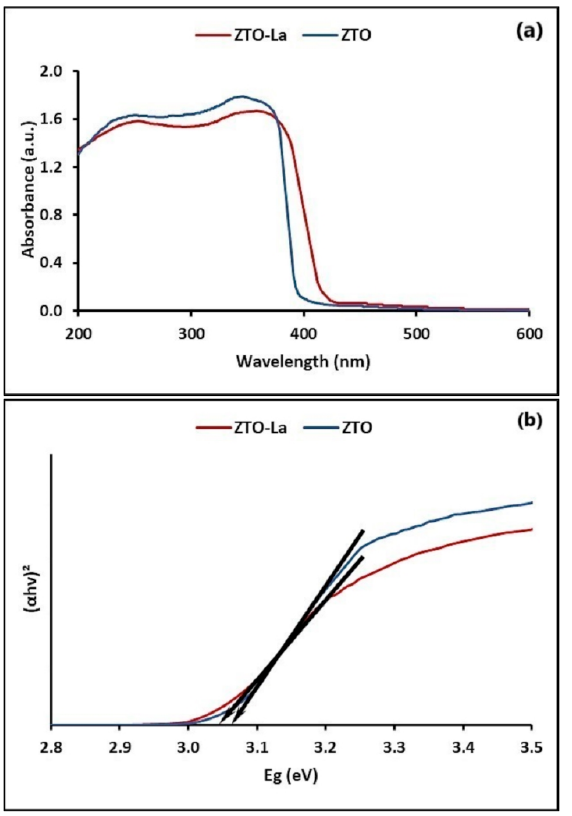
Figure 3. ( a ) UV-vis DRS and ( b ) plots of ( α hv) 2 vs. E g of ZnTiO 3 /TiO 2 /La and ZnTiO 2 /TiO 2